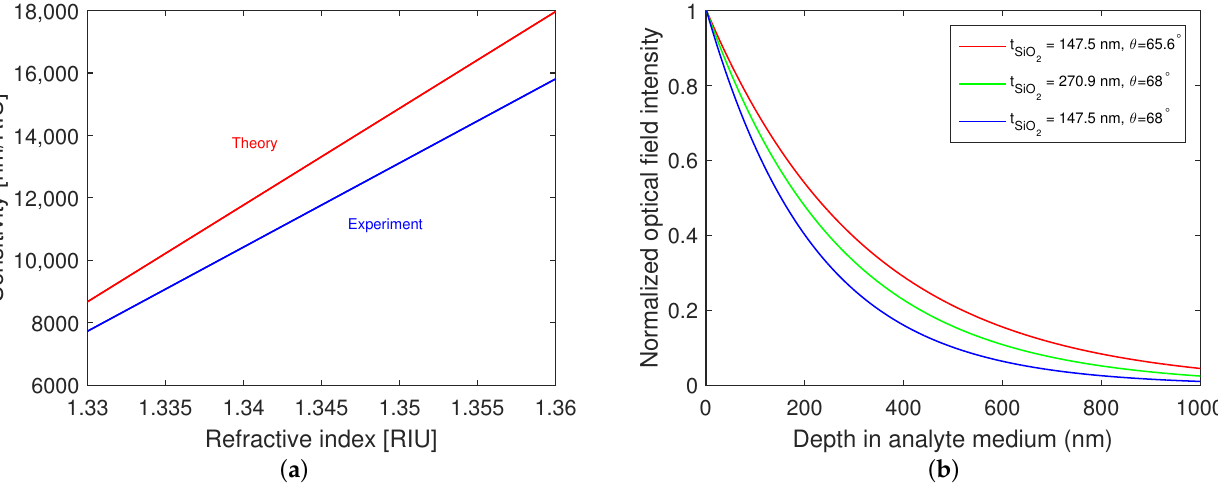
Figure 12. Comparison of RI sensitivity measured for a smaller angle of incidence (blue) and theoretical RI sensitivity (red) ( a ). Normalized optical field intensity distribution in the analyte (water) for different silicon dioxide layer thicknesses t SiO and angles of incidence θ ( b 2